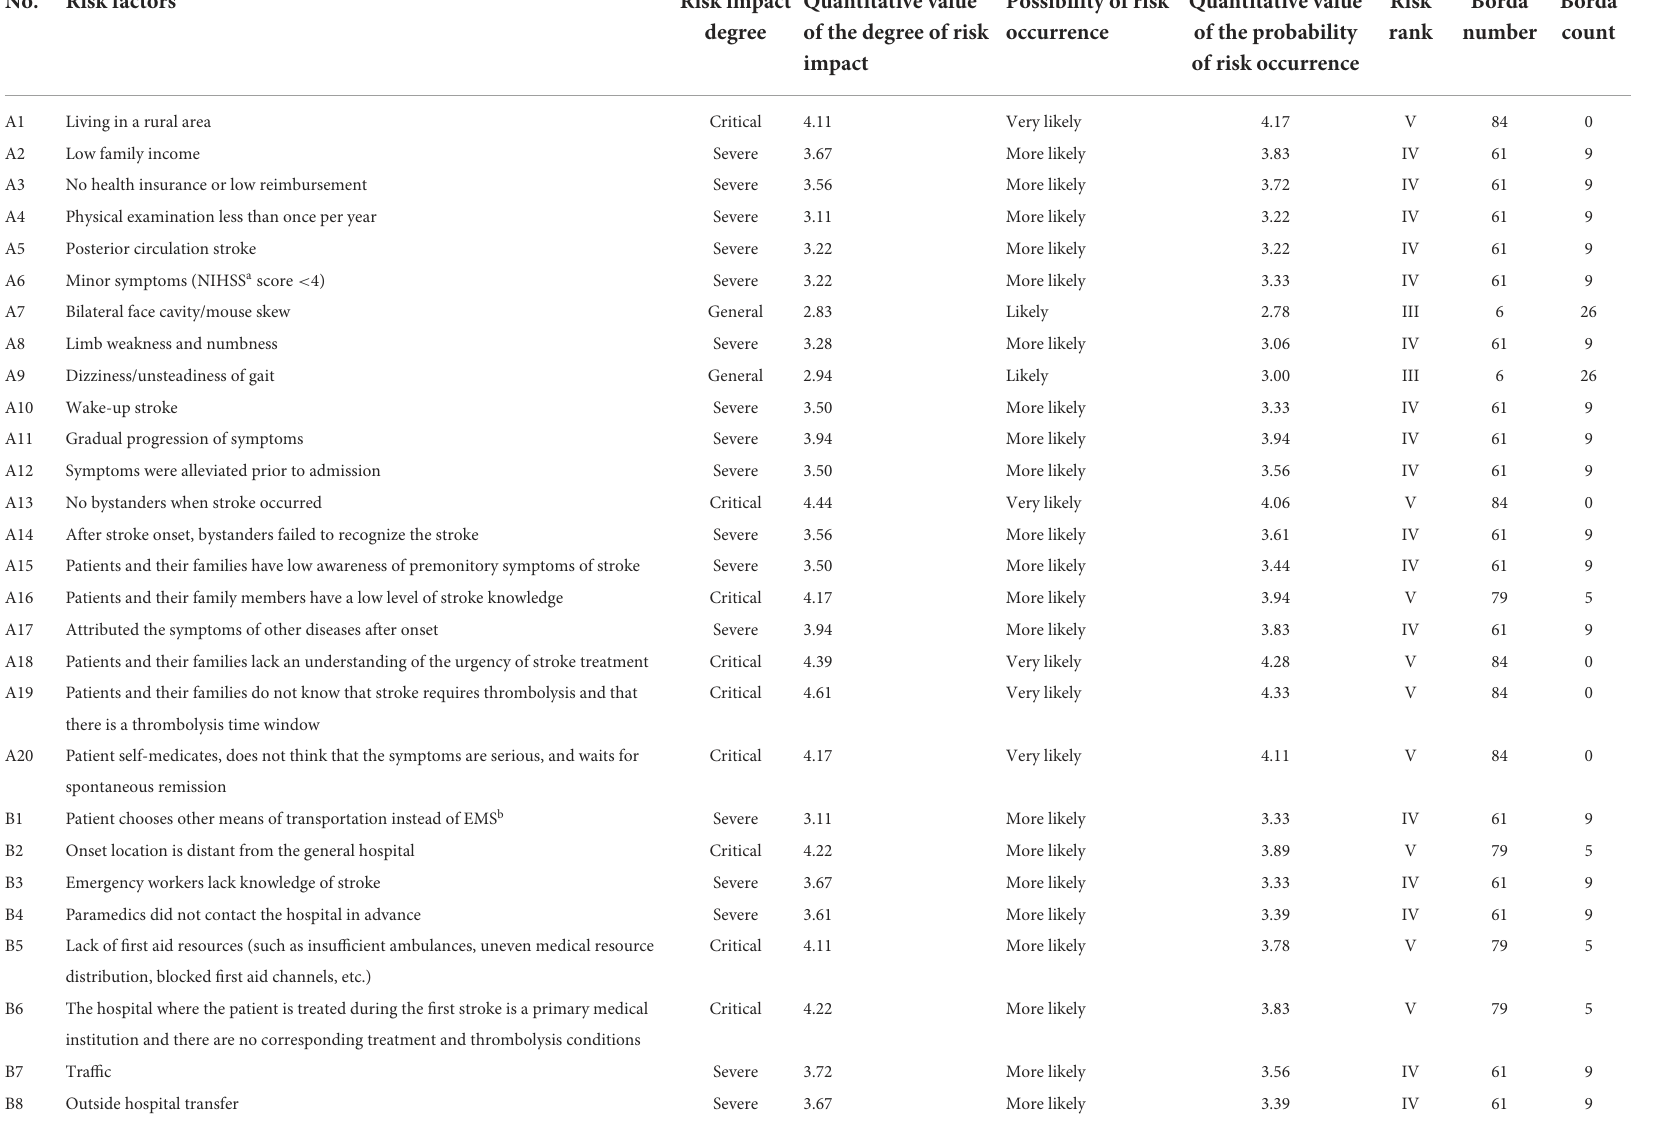
TABLE 3 Prehospital delay risk matrix for